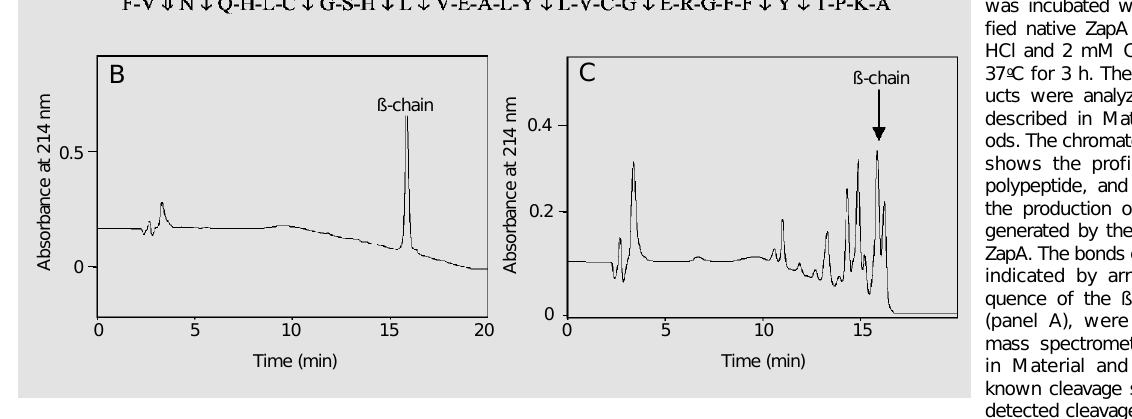
Figure 3. Hydrolysis of IgA by ZapA. IgA (54 µM) was incubated in 50 mM Tris-HCl and 2 mM CaCl 2 , pH 8.0, at 37 º C for 24 h without (panel A) or with (panel B) 28 pM ZapA. The incubation mix- tures were analyzed by HPLC as described in Material and Meth-